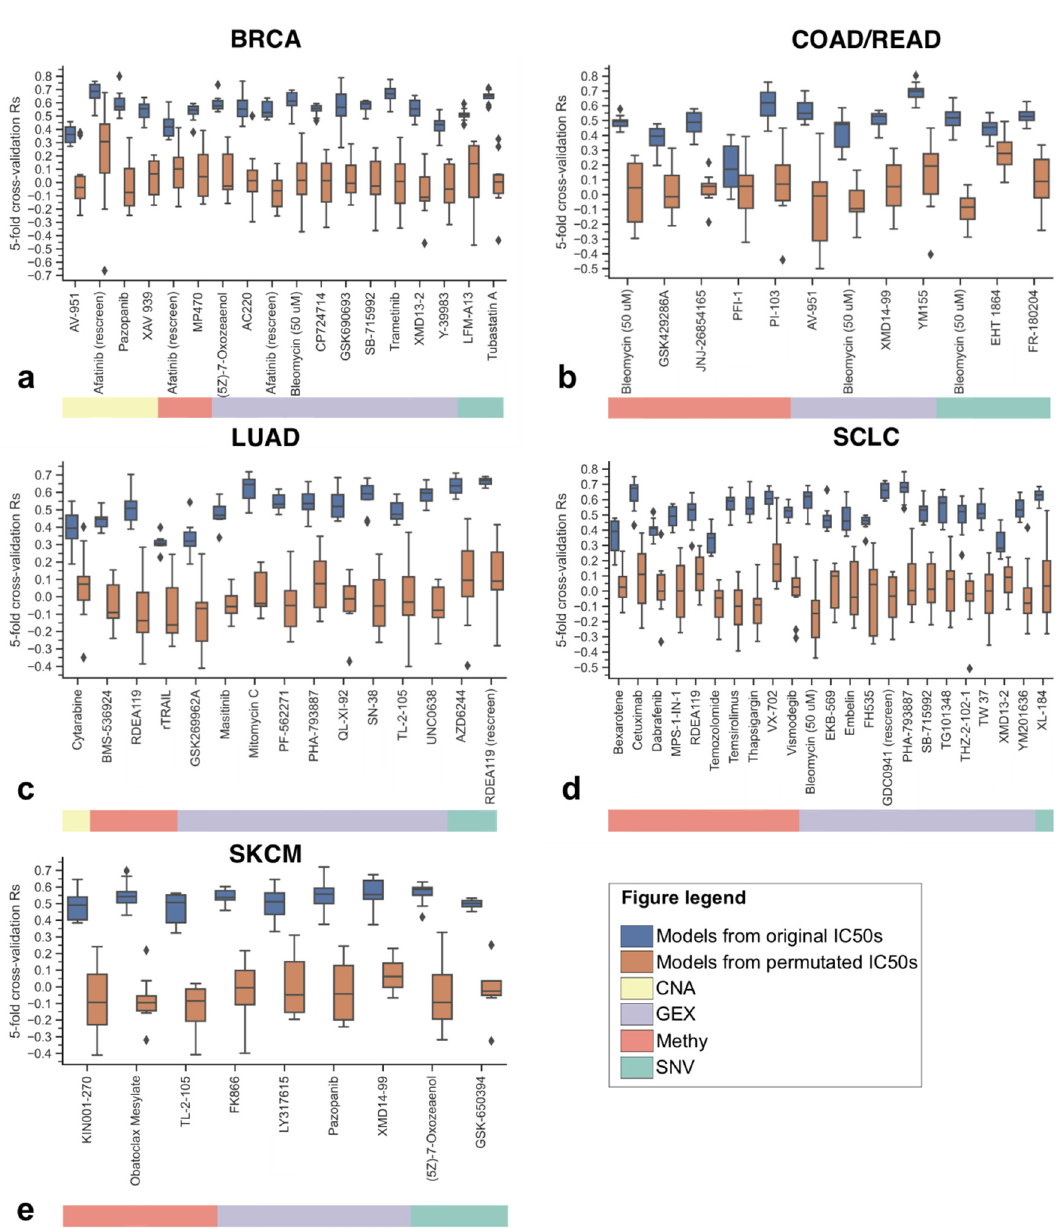
Figure 2. Performances of the 77 predictive XGB-OMC models using real log IC50 values (blue) and their corresponding models using permutated log IC50 values (orange). In each case, performance is calculated as Spearman’s correlation (R s ) between predicted and observed log IC50 values (the boxplot is formed with the five validation R s values from the five-fold cross-validation using the full dataset for that case). All five cancer types are shown ( a : BRCA, b : COAD / READ, c : LUAD, d : SCLC, e : SKCM), each predictive model identified by its drug (name) and molecular profile (horizontal colour bar below each plot; see legend for correspondence). Of all models, the model for PFI-1 in COAD / READ is by far the worst performer when compared to the permutated log IC50s ( p -value = 0.27). This model obtains borderline performance on not only the test set (R s of 0.31), but also on the validation set (R s of 0.29). The odds that the other models are being obtained by chance are very unlikely ( p < 2.2 × 10 − 16 , t-test). BRCA: breast invasive carcinoma, COAD / READ: colorectal adenocarcinoma / rectum adenocarcinoma, LUAD: lung adenocarcinoma, SCLC: small cell lung cancer, and SKCM: skin cutaneous melanoma.